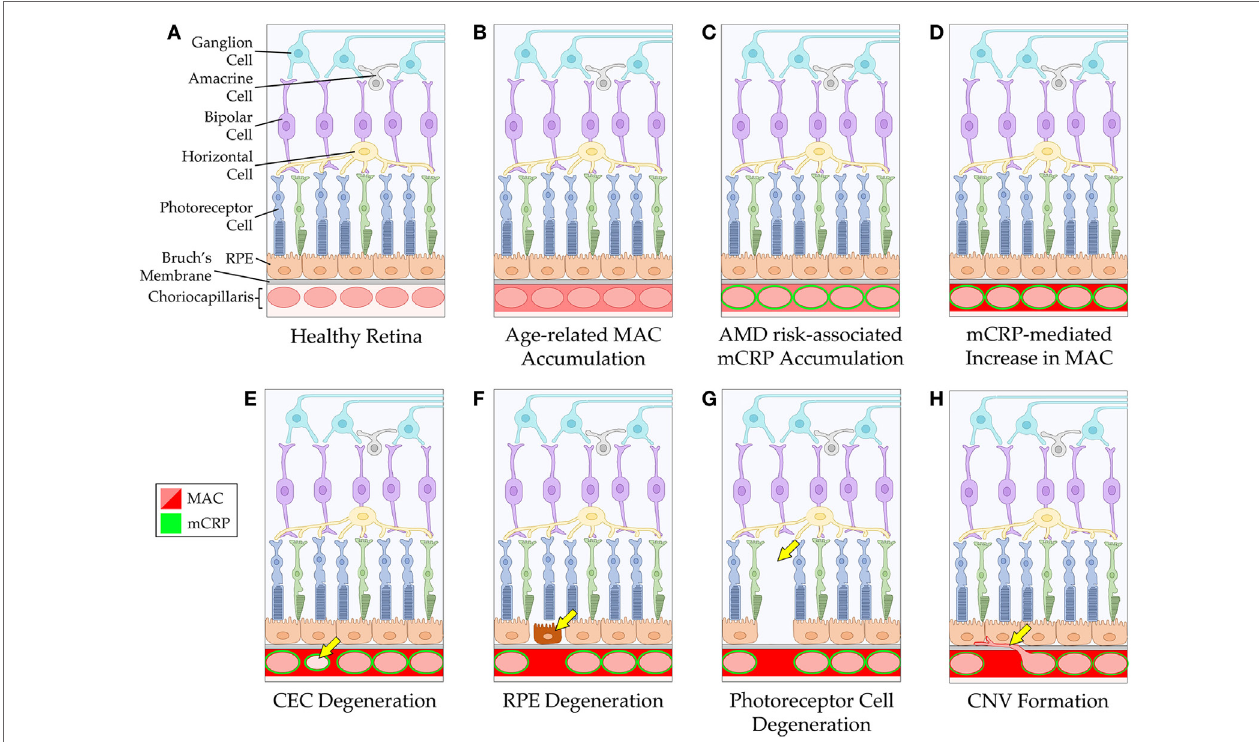
FiGURe 1 | Schematic of mCRP-associated age-related macular degeneration (AMD) pathogenesis. The healthy retina and choriocapillaris is depicted in (A) . With advancing age, the membrane attack complex (MAC) accumulates around the vessels of the choriocapillaris (B) . In individuals with an increased genetic risk for AMD ( via the CFH Y402H polymorphism), mCRP accumulates around the vessels of the choriocapillaris (C) , and this may lead to increased complement activation and subsequent elevation in MAC levels in the tissue (D) . The mCRP- and/or MAC-mediated changes to the tissue environment may result in CEC death and degeneration of the choriocapillaris (e) . Loss of the vessels of the choriocapillaris can cause dysfunction and degeneration of the RPE (F) , and eventually the photoreceptor cells (G) . Alternatively, loss of choriocapillaris vessels can lead to choroidal neovascularization formation (H) . RPE, retinal pigment epithelium; CEC, choroidal endothelial cell; CNV, choroidal